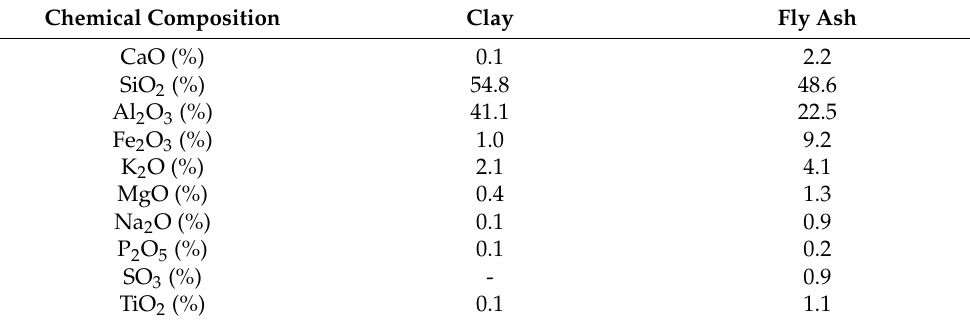
Figure 1. SEM image of kaolinite at 20 µ m. Table 1. Oxide compositions of clay and class F fly ash.